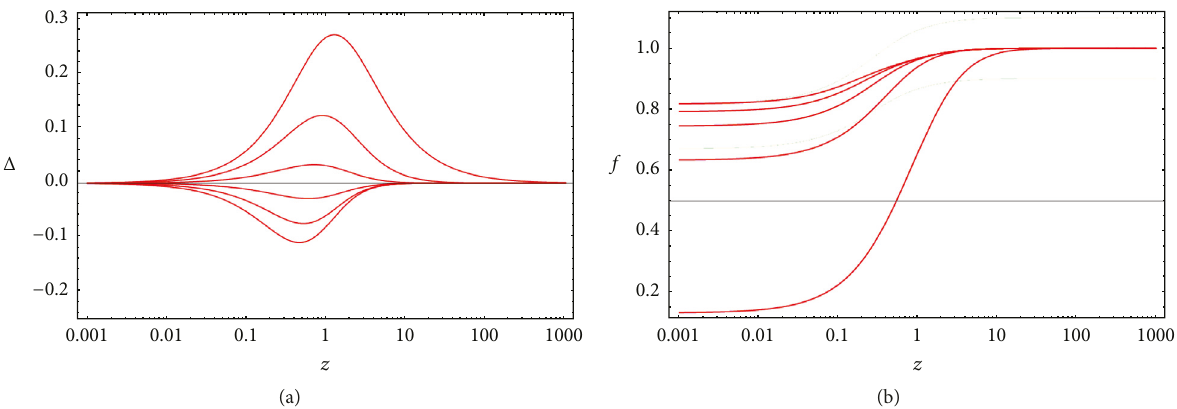
Figure 3: In (a) we obtain our model with an equidistant grid spacing, split by five steps with the same distance. (a) shows slight departures from our framework and the concordance model. This is even confirmed in (b). There, we report the behavior of the growth factor 𝑓(𝑎) in terms of the redshift 𝑧 . Both redshift domains span from 𝑧 = 0 to 𝑧 ≃ 1000